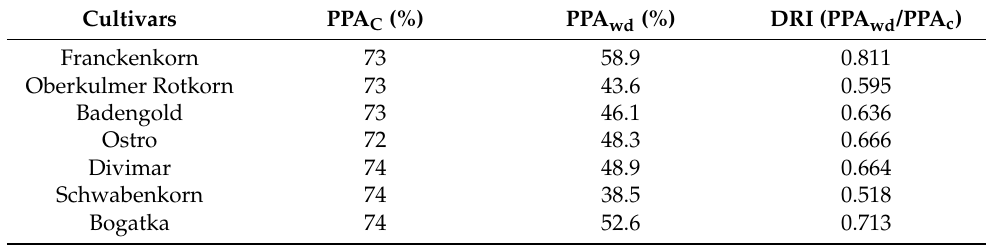
Table 4. Effect of wheat varieties and drought stress on physiological plant activity and drought resistance index